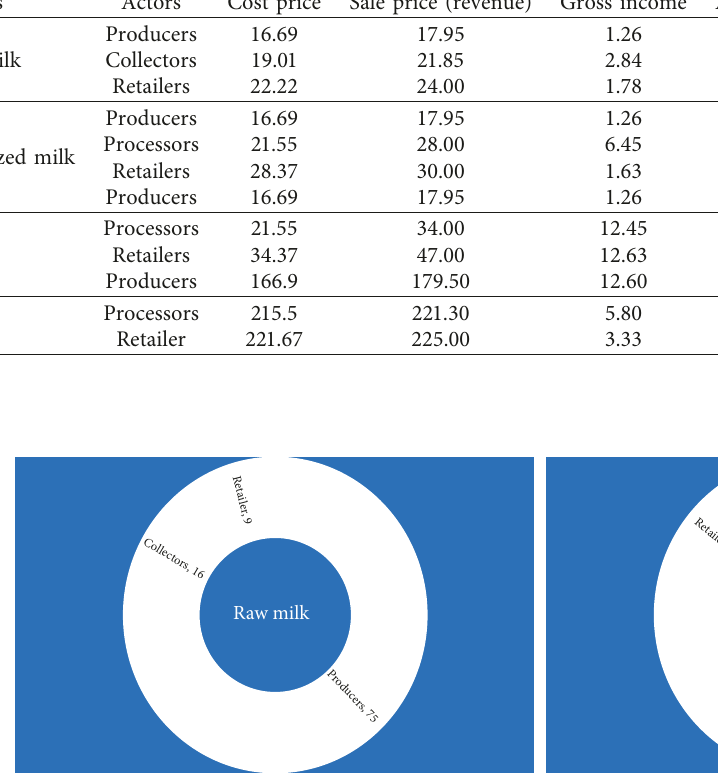
Figure 8: Value share of actors in raw milk and